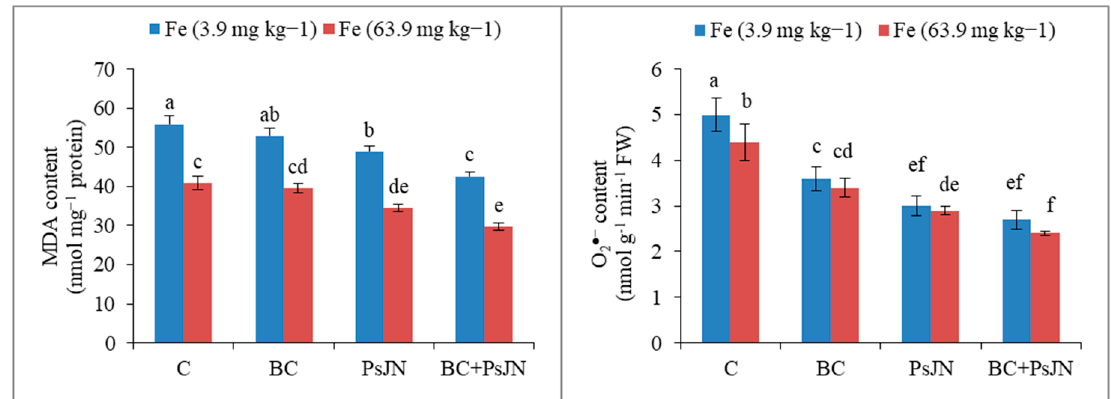
Figure 5. The effect of biochar- Burkholderia phytofirmans PsJN integration on stress related metabolites of